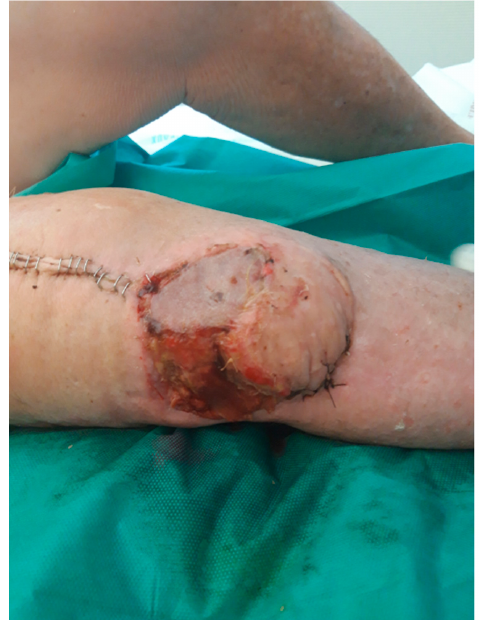
Figure 2. The patient developed a wound healing disorder (skin necrosis) anterolateral to the ope- rational area (knee joint).